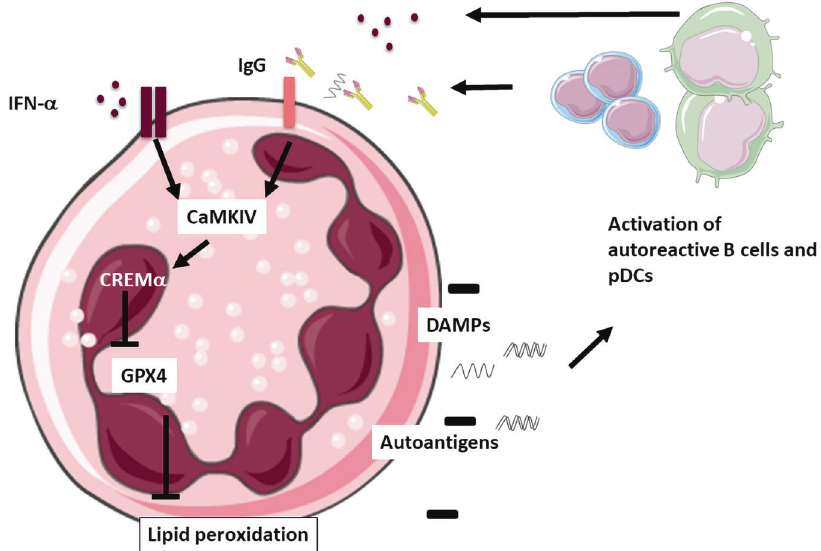
Fig. 1 The vicious circle of neutrophil ferroptosis in SLE. Type-I IFNs and autoantibodies in SLE sera induce neutrophil ferroptosis. Neutrophilic cell death releases autoantigens and thereby activates autoreactive B cells and pDCS, which leads to further production of autoantibodies and type-I-IFNs. Images are from